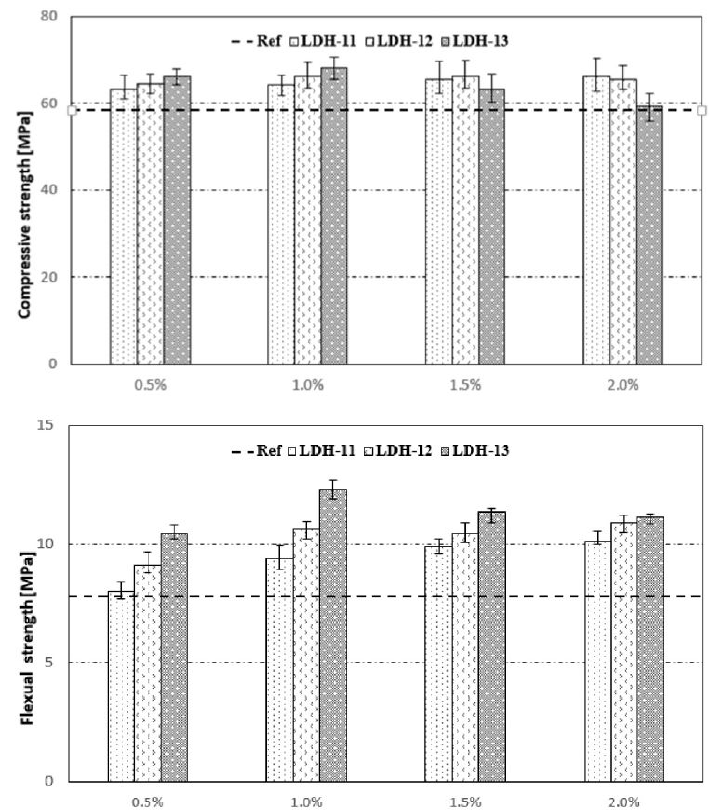
Figure 4. LDH dosage and effect on compressive and flexural strength. LDH-11, LDH-12, LDH-13 refer to mean particle size of 9.5 µ m, 6.3 µ m and 3.2 µ m respectively. Reprinted from [97] with permission from